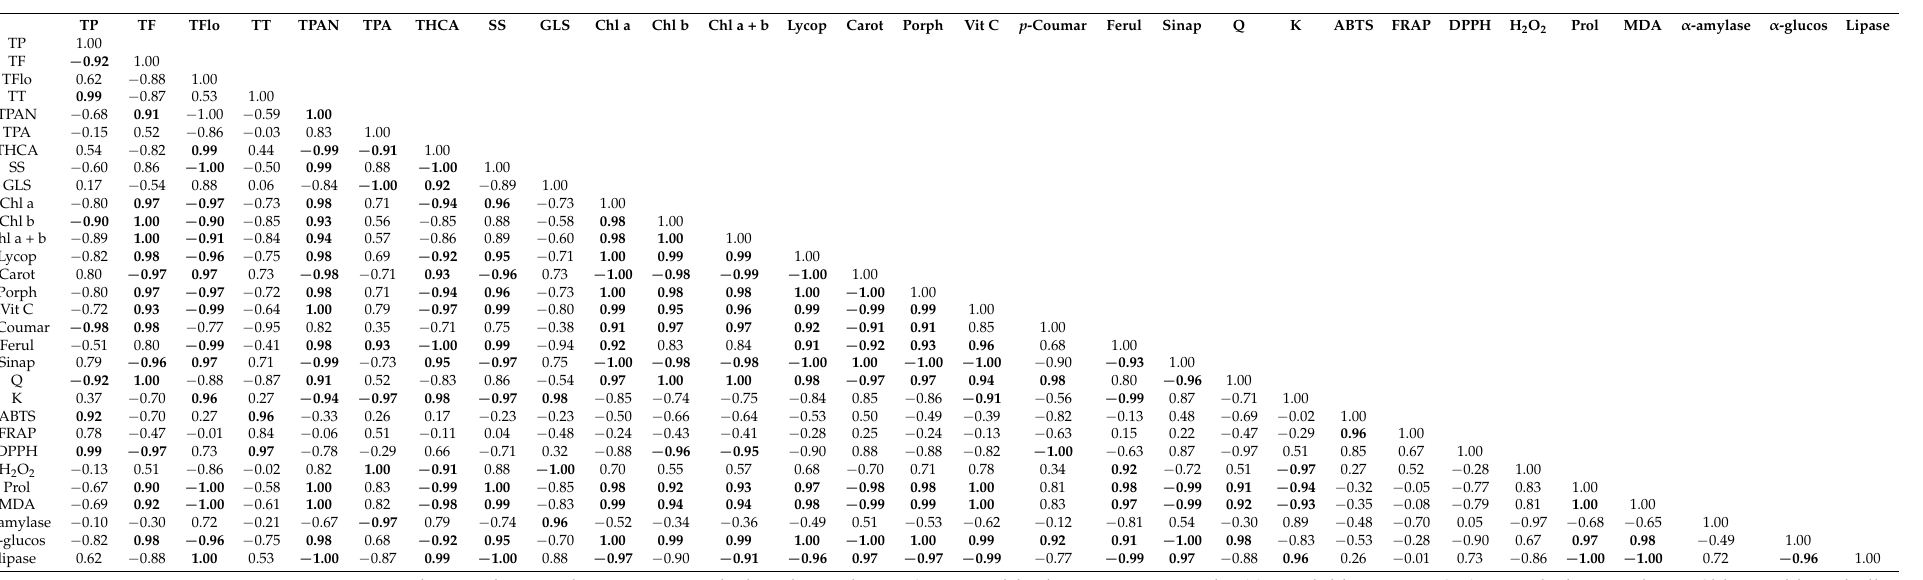
Table 5. Pearson’s correlation coefficients between the measured variables of young broccoli